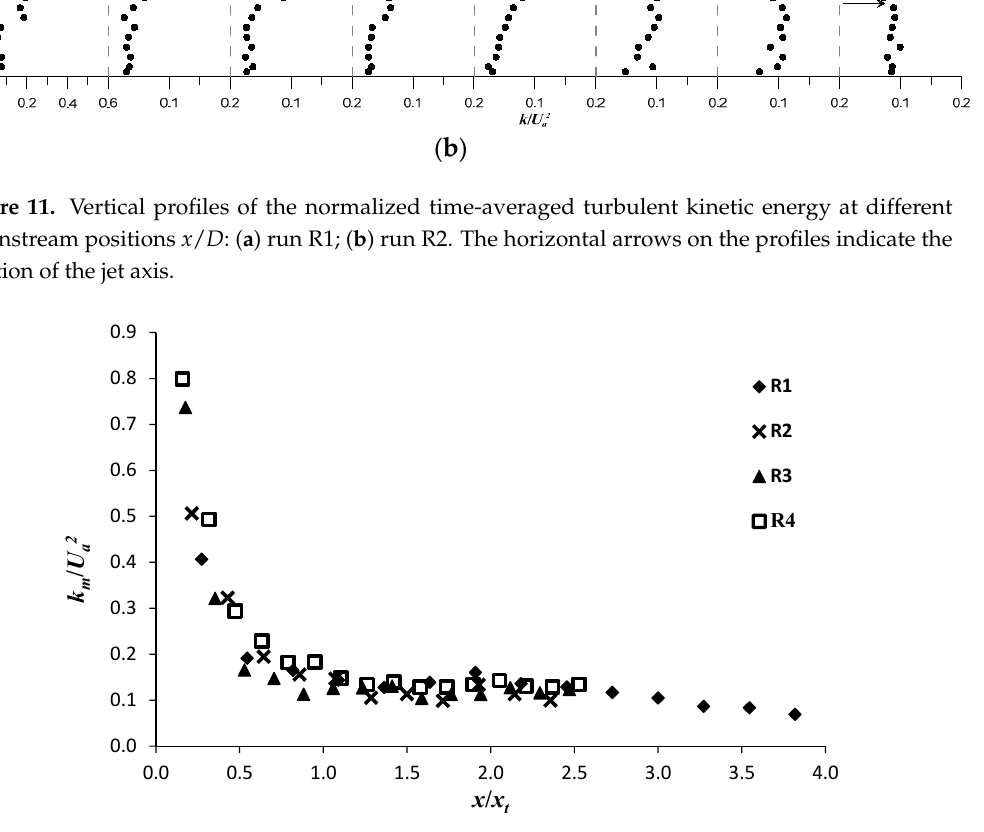
Figure 12. Decay of the maximum turbulent kinetic energy k / U a 2 as a function of x / x t .